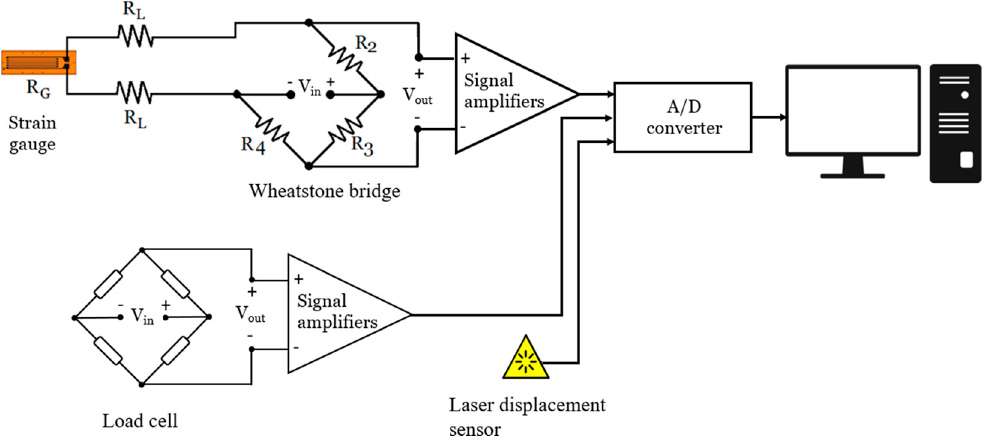
Figure 7. Schematic representation of the measurement system used in the test.